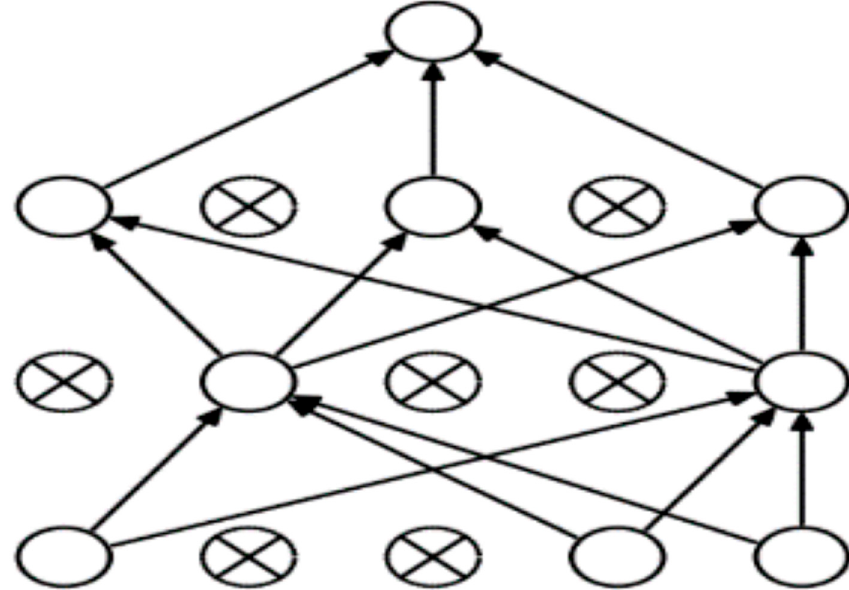
Figure 4. Dropout process [52].